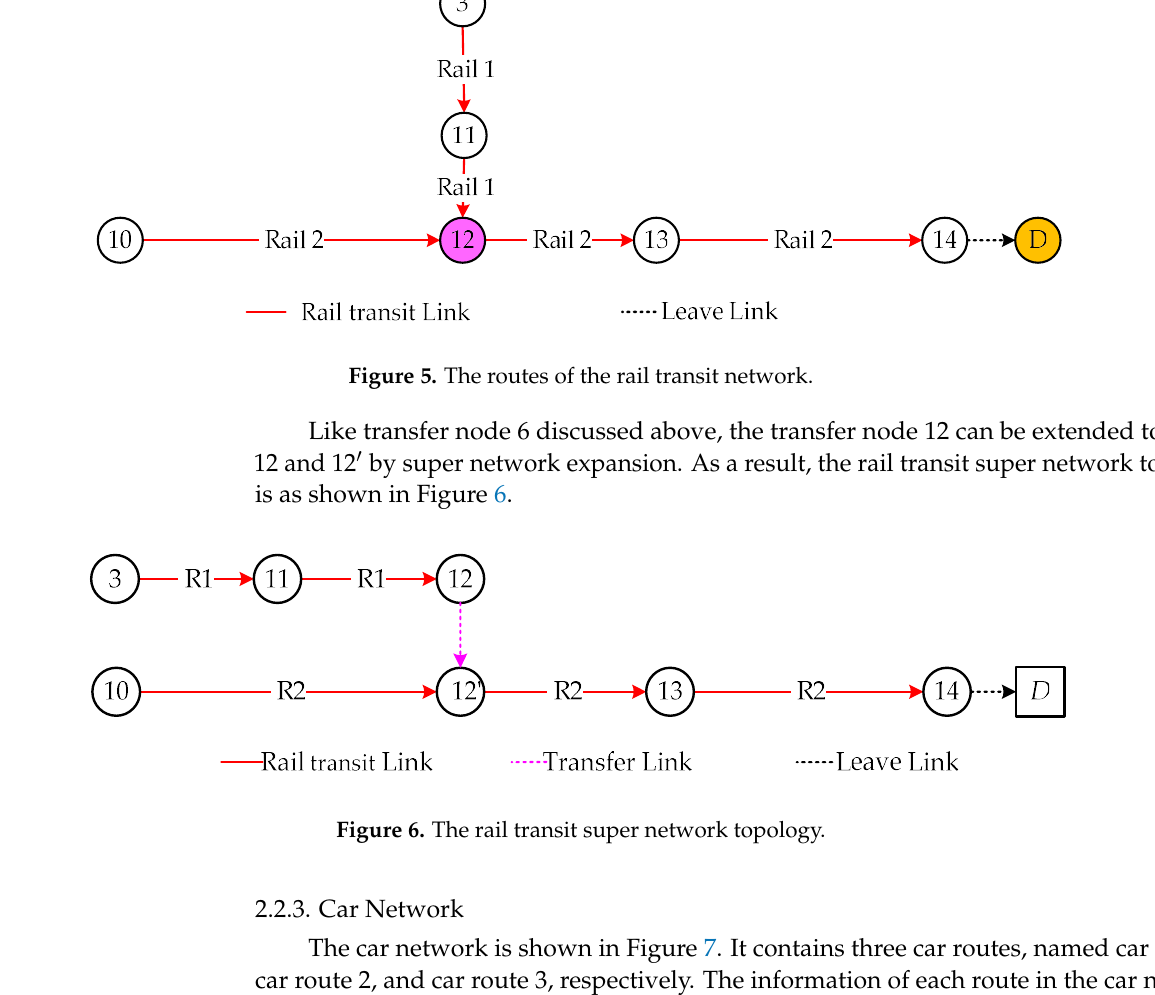
Figure 6. The rail transit super network topology.